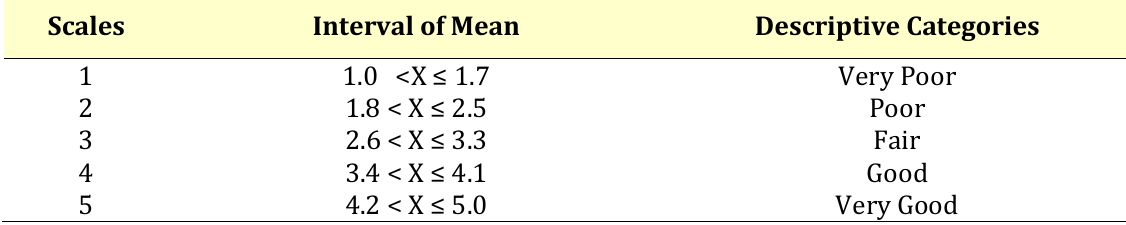
Table 1. Data Conversion Table was adapted from (Suharto 2006) in Alex Sander (2018 )